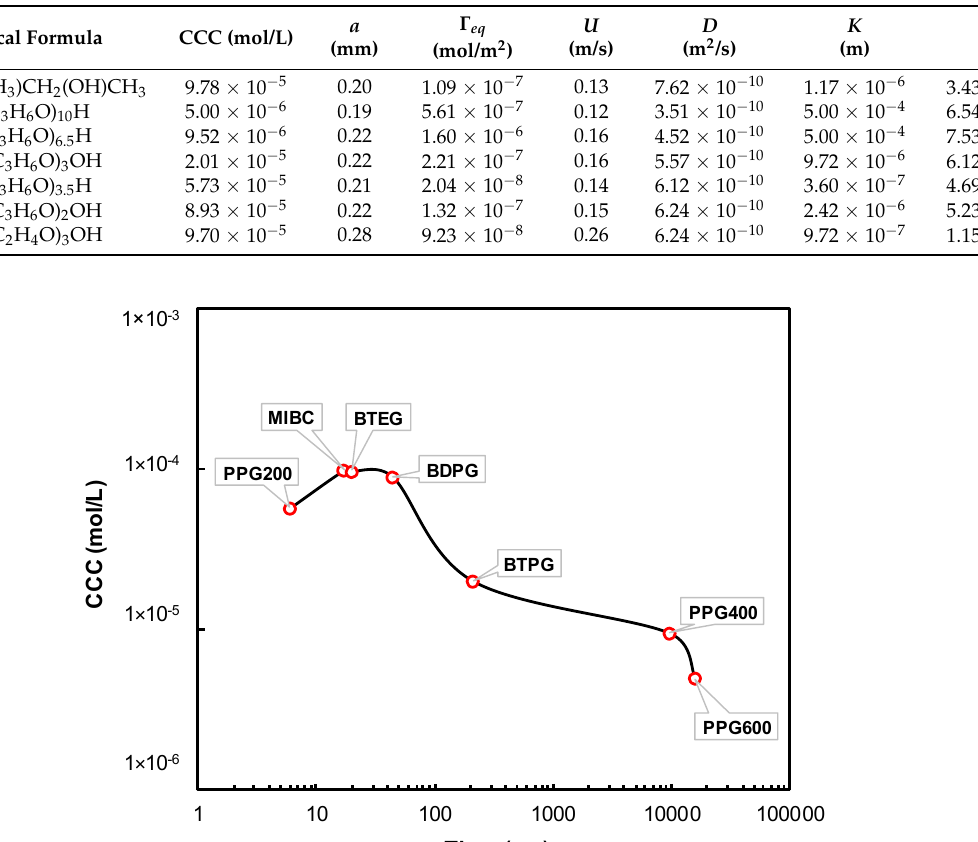
Table 1. Parameters required to calculate the adsorption kinetics of the frothers on the surfaces of the rising bubbles at the CCC of each frother (Bubble diameters is derived from Figure 3a).